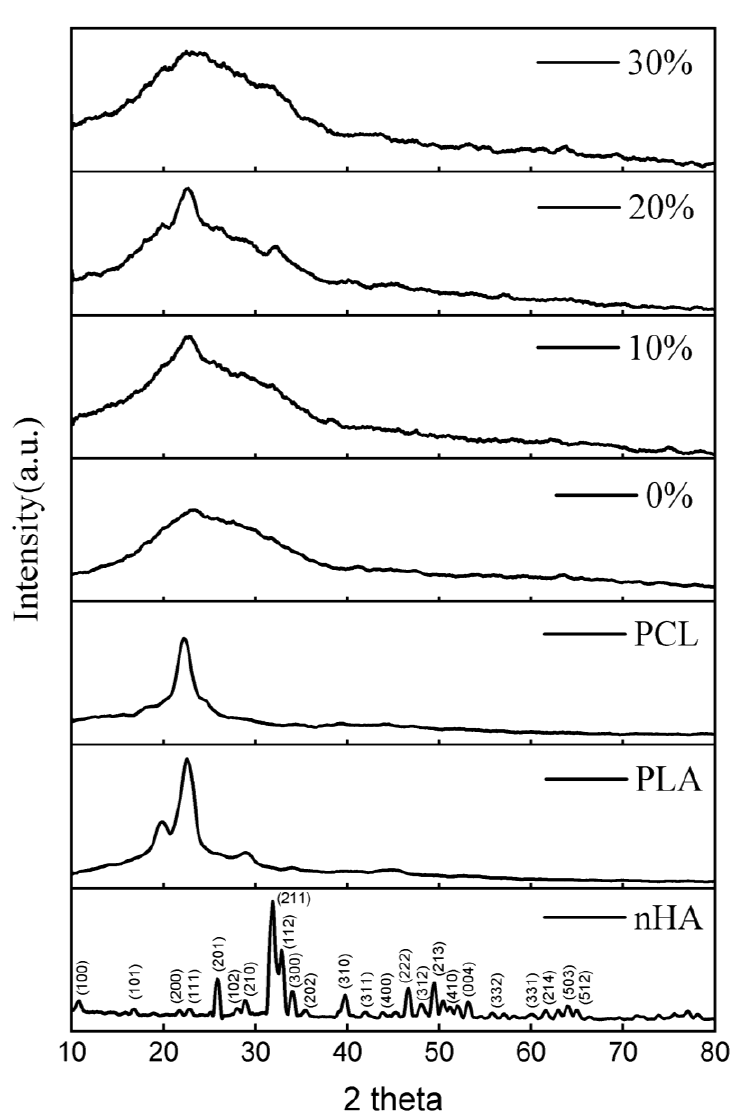
Figure 2. XRD patterns of the nHA, and PLA/PCL/HA biocomposites with various concentrations of nHA.